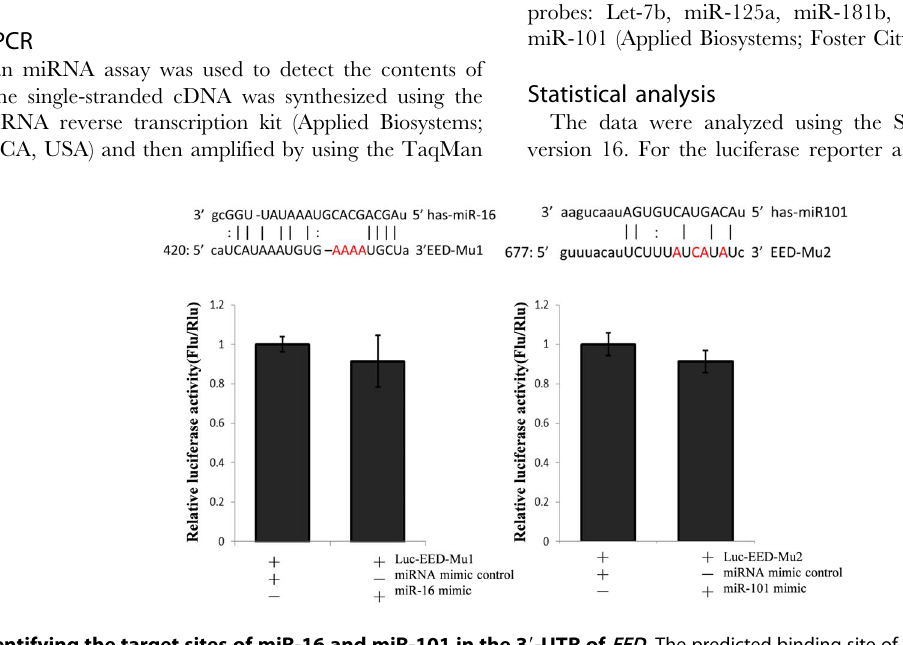
Figure 7. Identifying the target sites of miR-16 and miR-101 in the 3 9 -UTR of EED . The predicted binding site of miR-16 and miR-101 in the 3 9 -UTR of EED was mutated (designated as Luc-EED-Mu1 and Luc-EED-Mu1, respectively). HEK293T cells were transfected with miR-16 or 101, and the mutant EED 3 9 -UTR reporter vectors separately, with pRL-TK as the transfection control. The luciferase activity was detected 48 h after transfection. Results were analyzed with the Student’s t-test. * P , 0.05, ** P ,